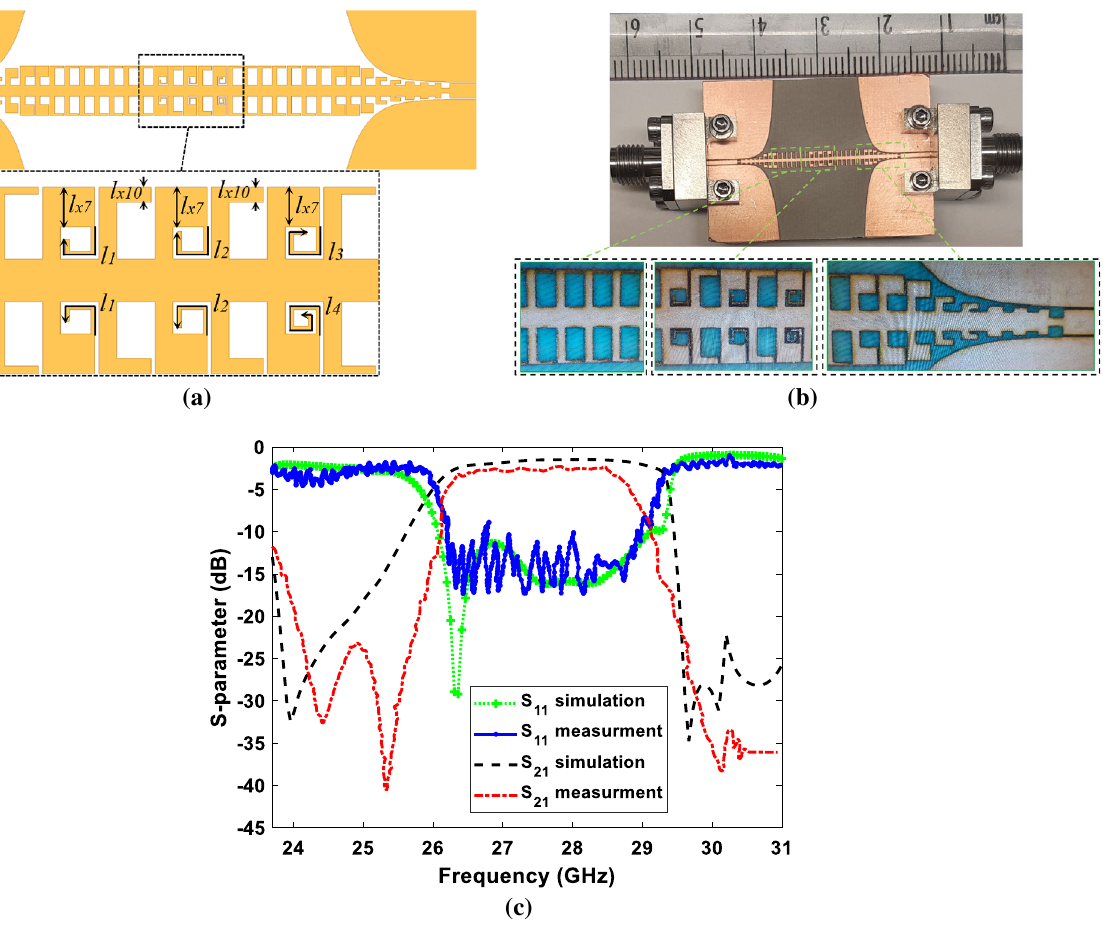
Figure 7. Proposed SSPPs filter ( a ) Schematic picture of the designed SSPPs filter consists of stub resonators with different lengths. ( b ) The fabricated filter. ( c ) Simulated scattering Ansys 2021 (https:// www. cmc. ca/ ansys- campus- solut ions- cmc- 00200- 04847/) parameters compared to the measured